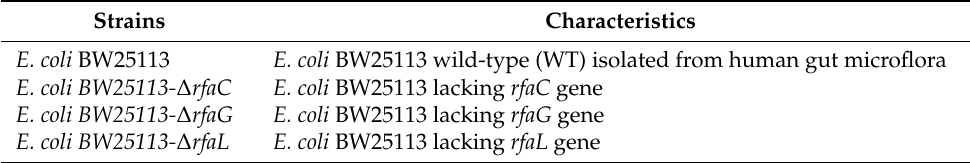
Table 1. Escherichia coli strains used in this study.